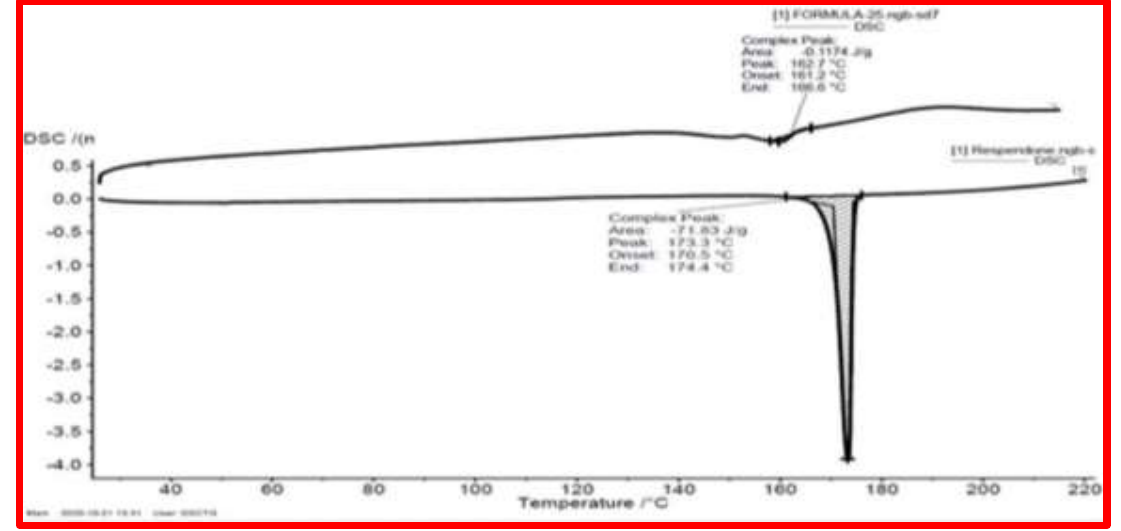
Figure 10. DSC of pure risperidone and the lyophilized F13 X-ray powder diffraction (XRPD)